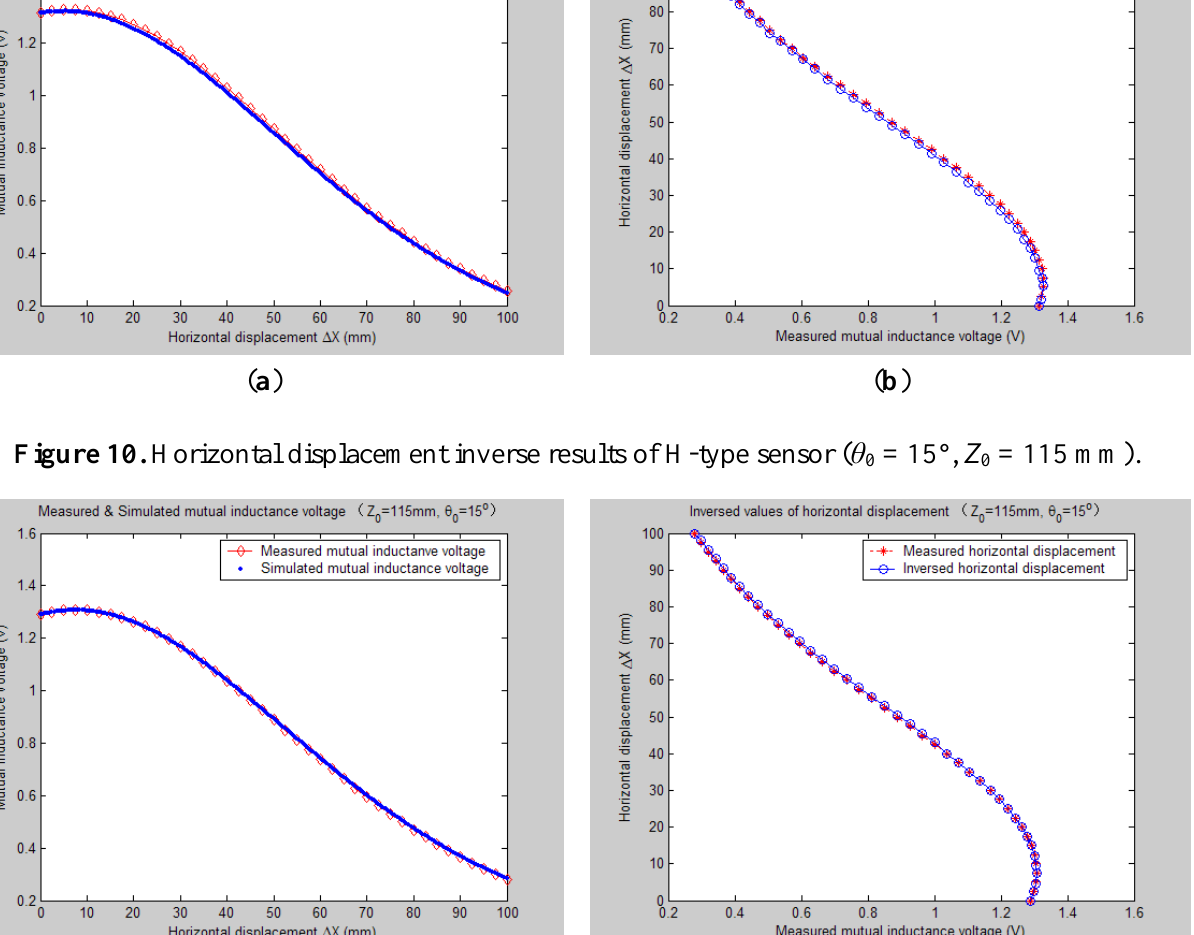
Figure 9. Horizontal displacement inverse results of H-type sensor ( θ